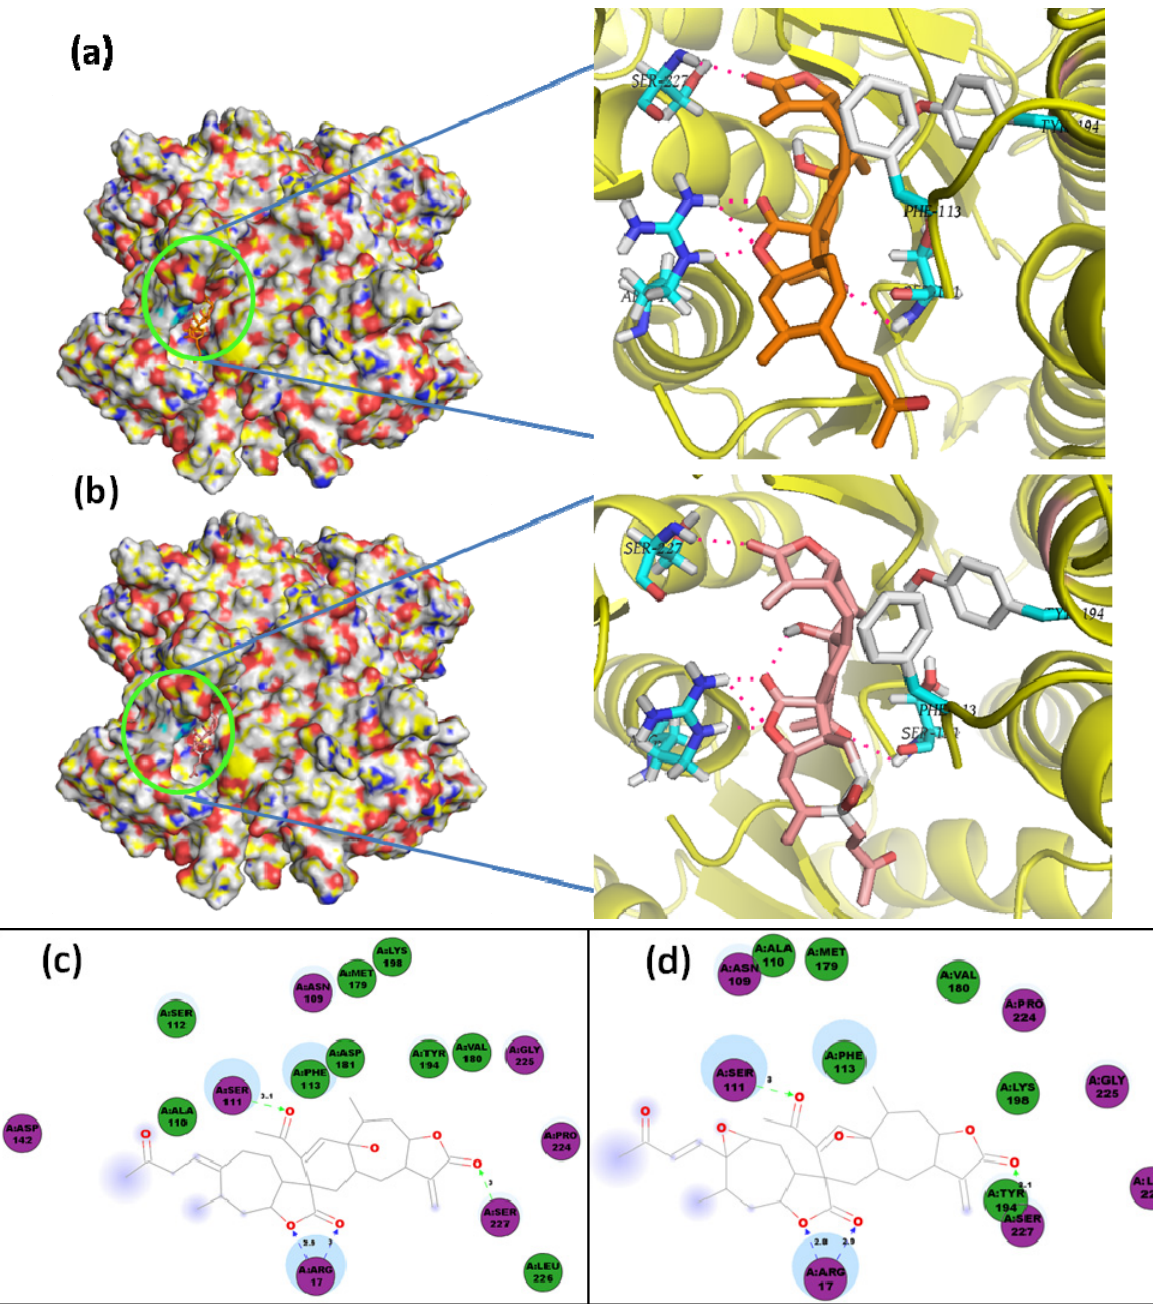
Figure 10. Lowest-energy docked pose with Lm PTR1 of: ( a ) sesquiterpene 75 ; ( b ) sesquiterpene 76 ; 2D representation of protein ligand interactions of: ( c ) compound 75 ; ( d ) compound 76